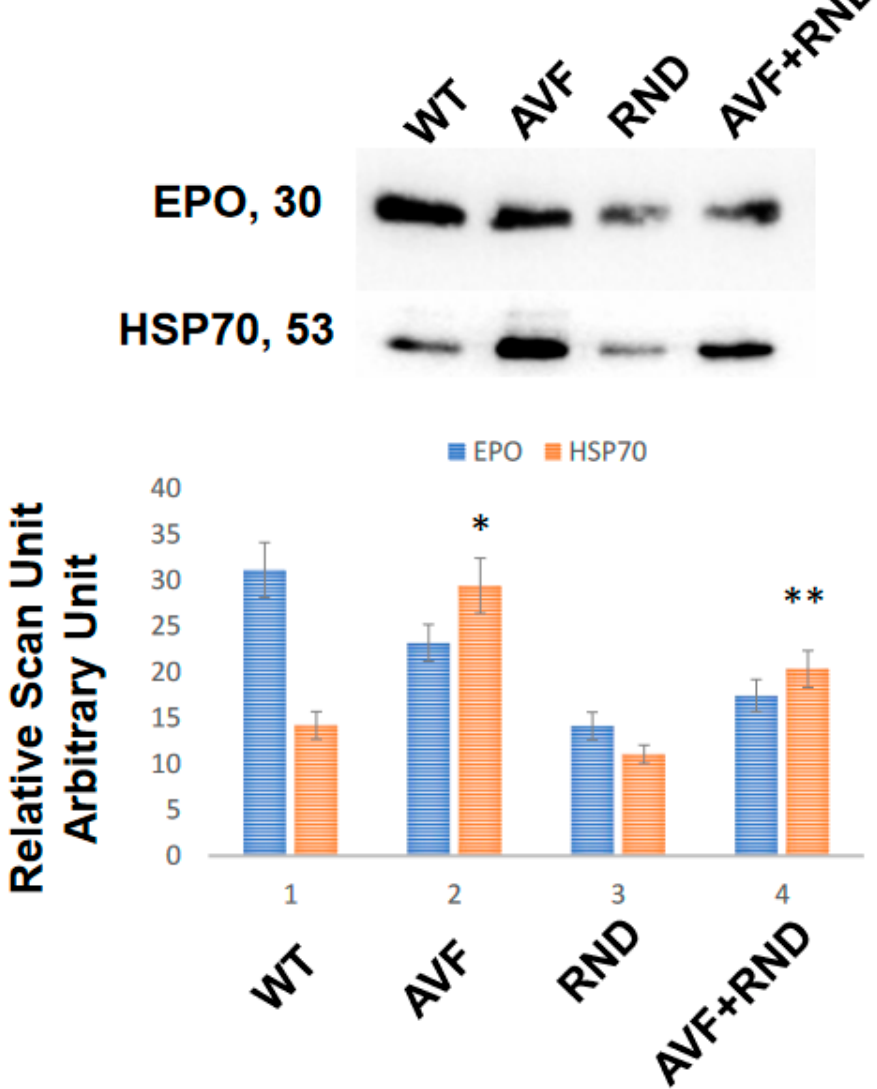
Figure 1. Blood levels of circulating exosomes in the C57BL/6J (WT-controls), AVF, RND, and AVF- RND male mice at 16 weeks. The upper gel panel represents levels of erythropoietin (EPO), and lower panel depicts exosomal marker heat shock protein 70 (HSP70). The bar graph represents mean ± SD from n = 5; *, p < 0.05 compared to WT; **, p < 0.05 compared with